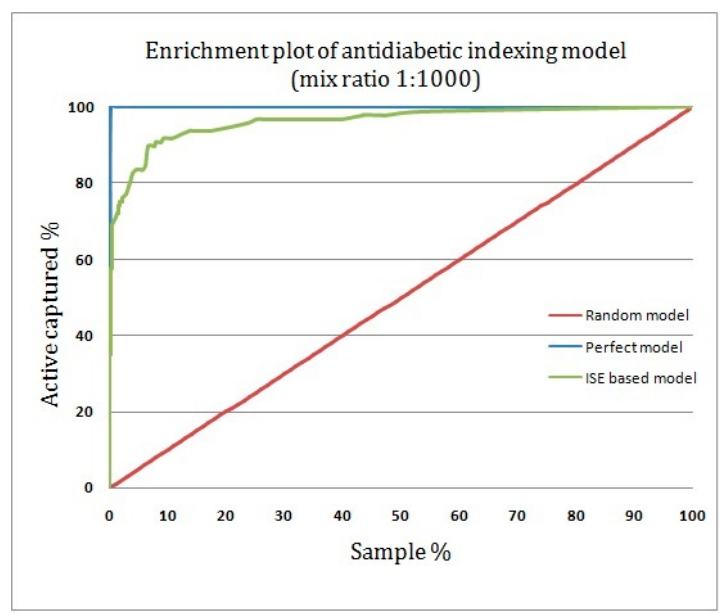
Figure 7. Enrichment plot of the anti-diabetic activity-indexing model.